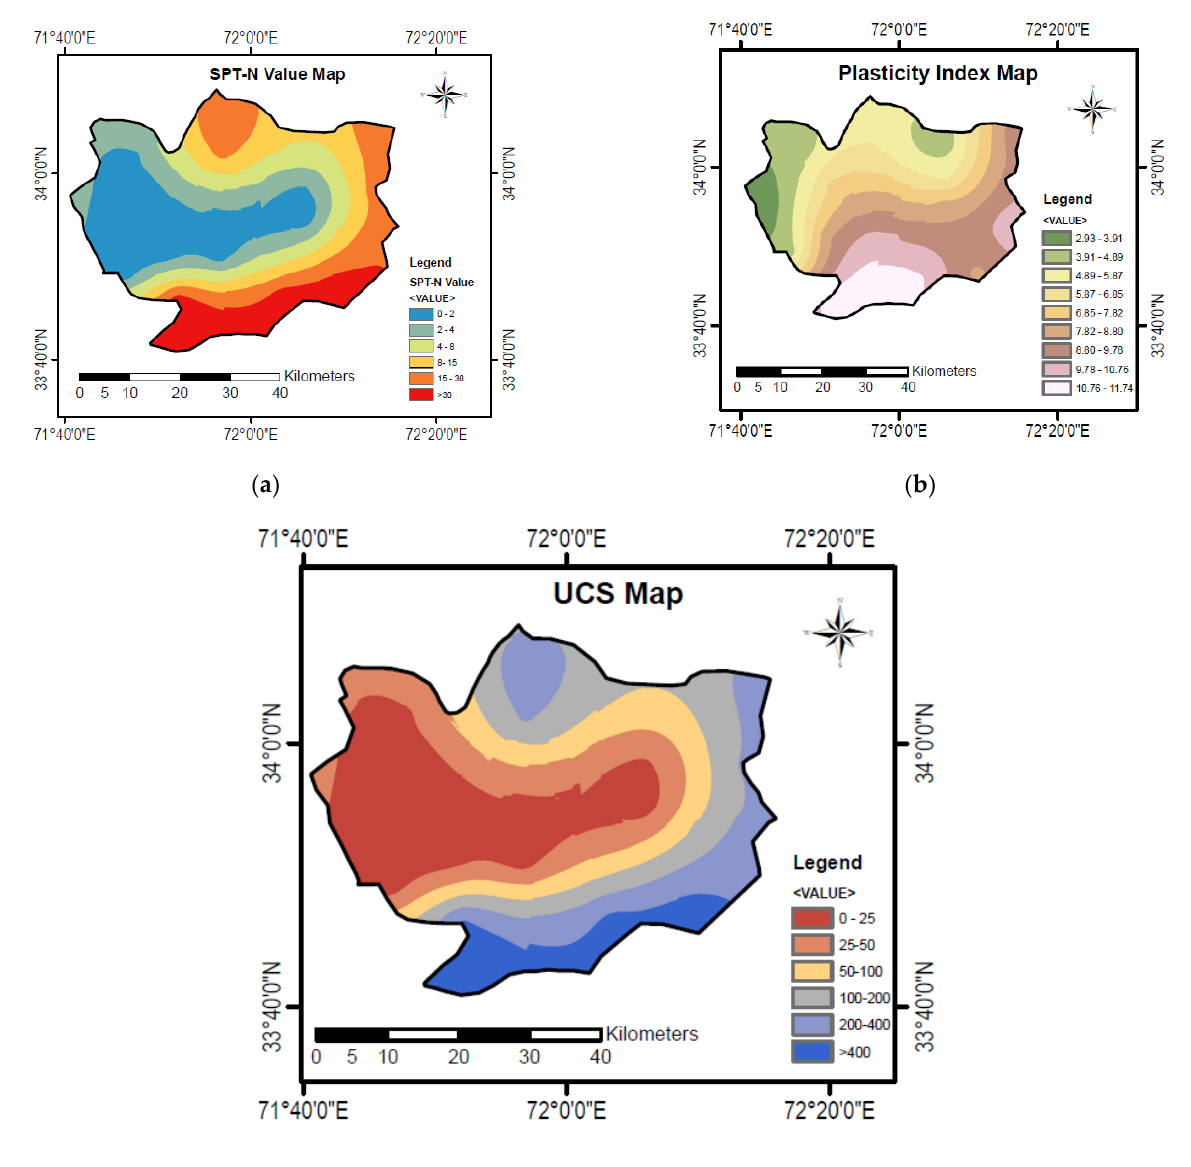
Figure 4 Figure 5. Digital map showing the distribution of geotechnical parameters over the study area ( a ) in-situ parameter SPT-N distribution; ( b ) Laboratory test parameter plasticity index distribution over the study area; and ( c ) unconfined compressive strength